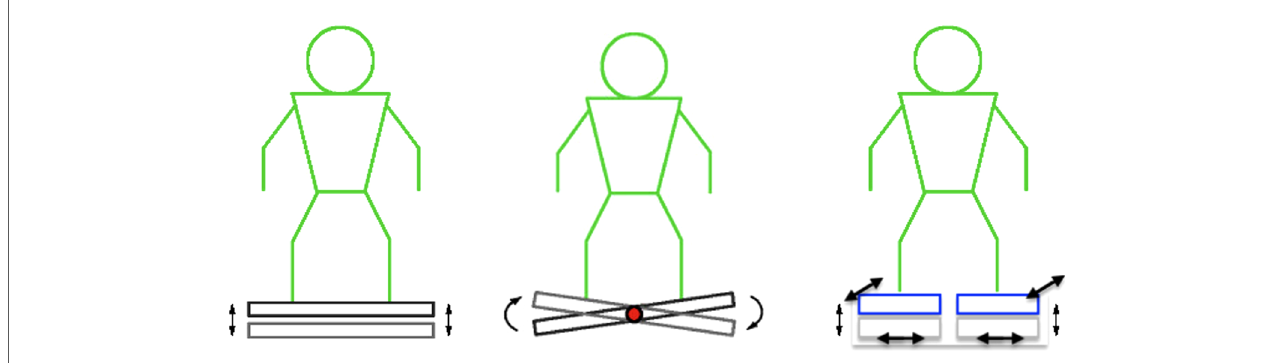
FIGURE 1 Different types of vibrating platforms. Whole-body vibration (WBV) types from left to right: sinusoidal vertical (SV-WBV), sinusoidal side-alternating (SS-WBV), and stochastic resonance (SR-WBV); source: mediplate.ch; SR-WBV customized by the